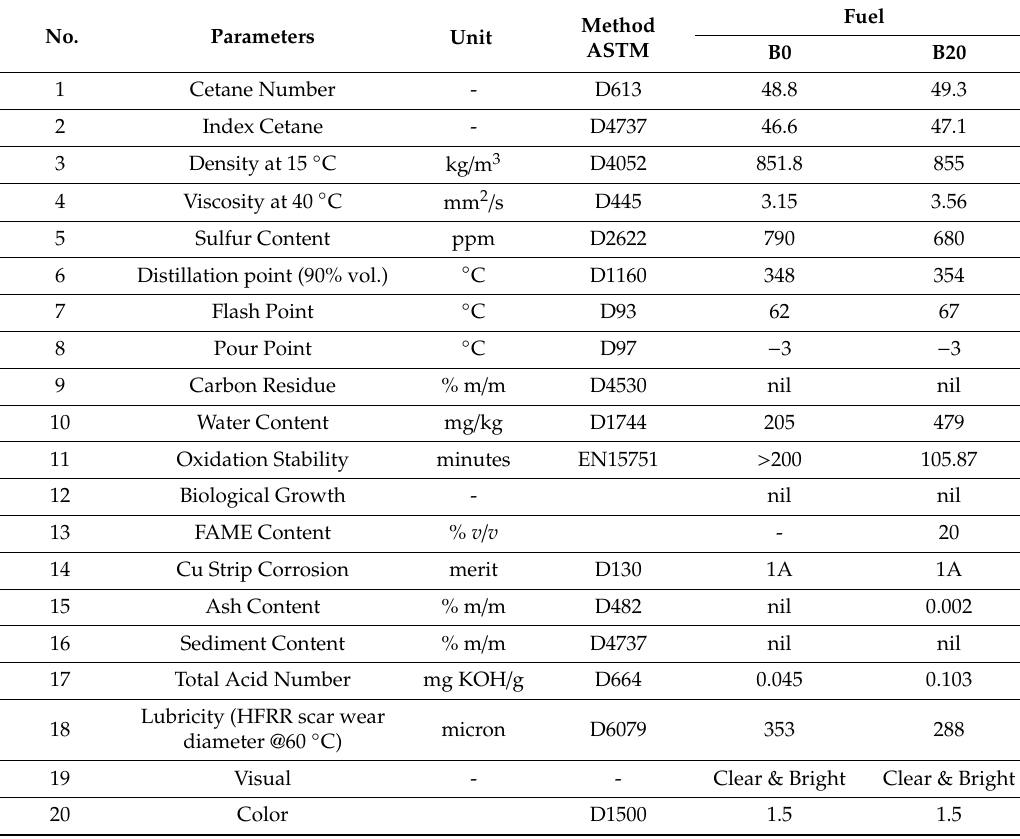
Table 1. Fuel properties for base fuel and B20